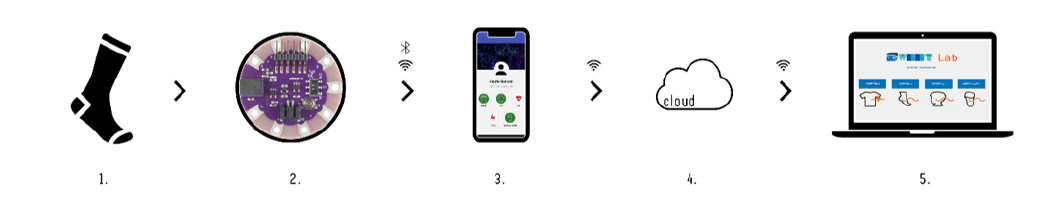
Figure 1. System Architecture: ( 1 ) SWEET Sock—Textile Unit; ( 2 ) SWEET Sock—Control Unit; ( 3 ) SWEET App; ( 4 ) Web Server; ( 5 ) SWEET